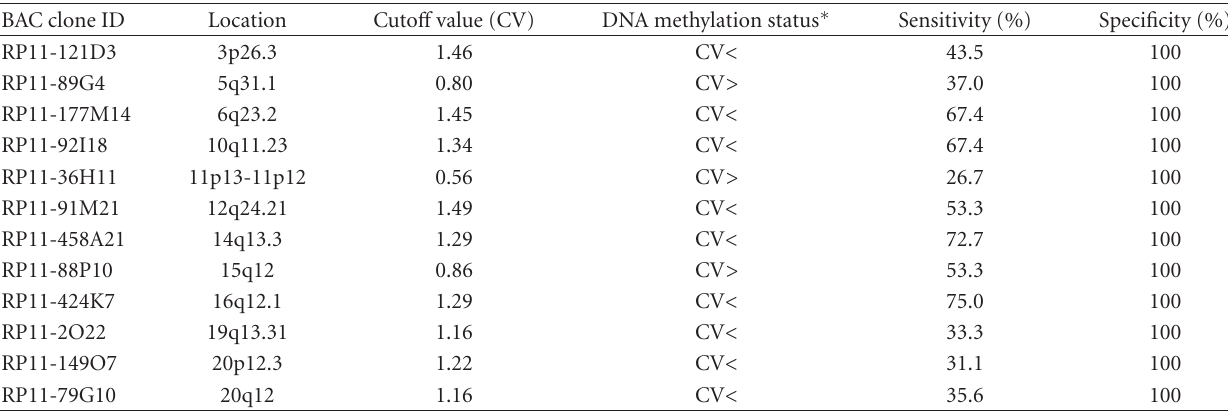
Table 2: Twelve BAC clones that were able to discriminate samples of cancerous tissue from samples of normal pancreatic tissue obtained from patients without ductal adenocarcinomas and samples of noncancerous pancreatic tissue obtained from patients with ductal adenocarcinomas in the learning cohort with 100% specificity.